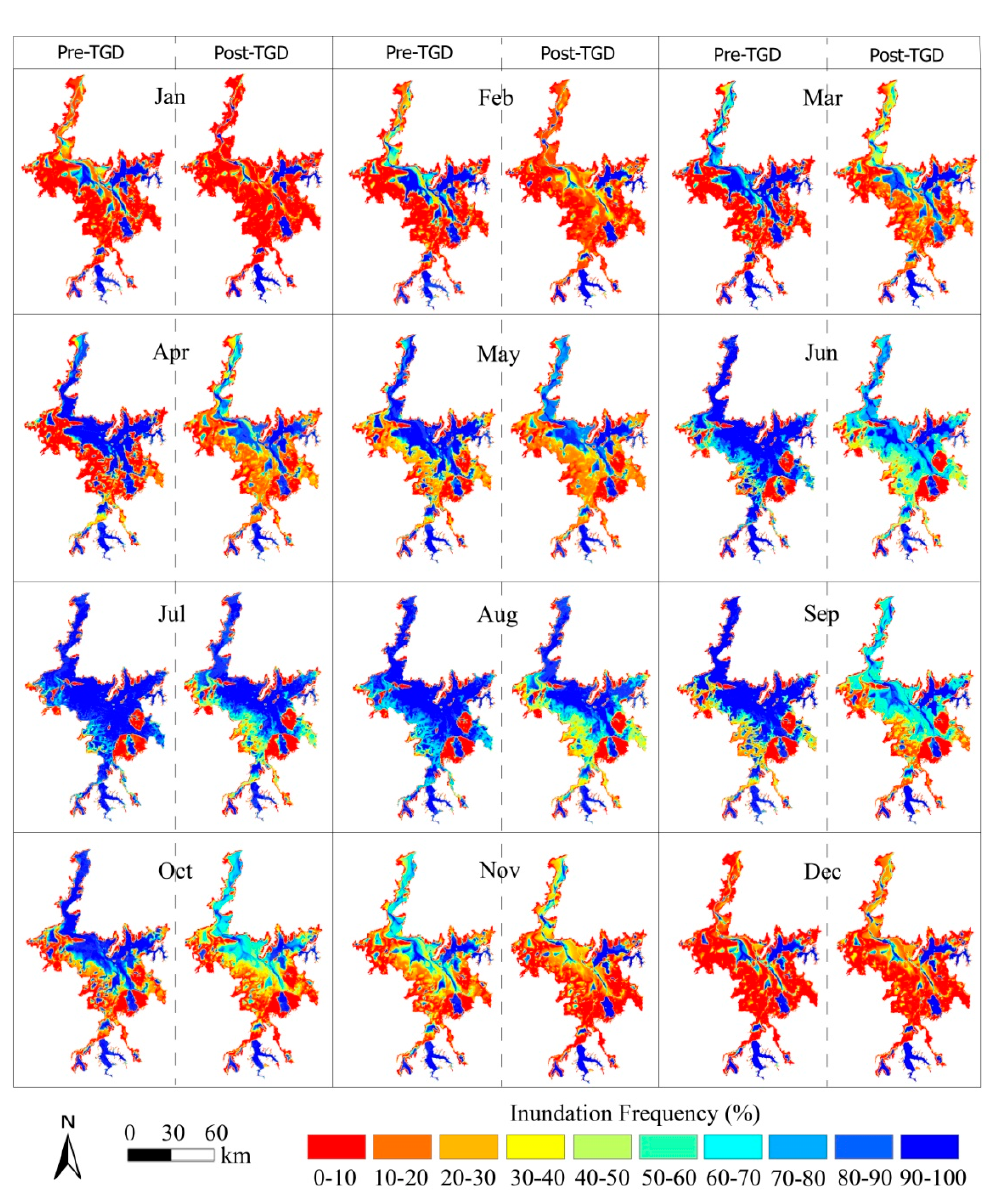
Figure 3. Poyang Lake’s monthly mean inundation frequency (IF) during the pre- and post-TGD periods derived from remote sensing (left column: pre-TGD; right column: